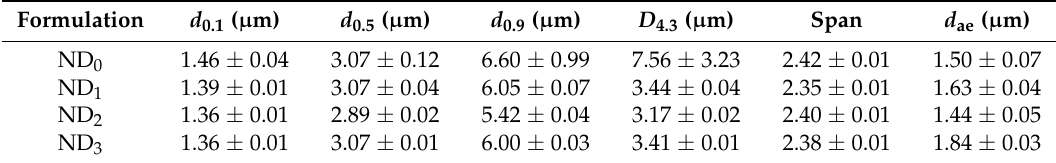
Table 2. Particle size of NTM DPIs ( n = 3).